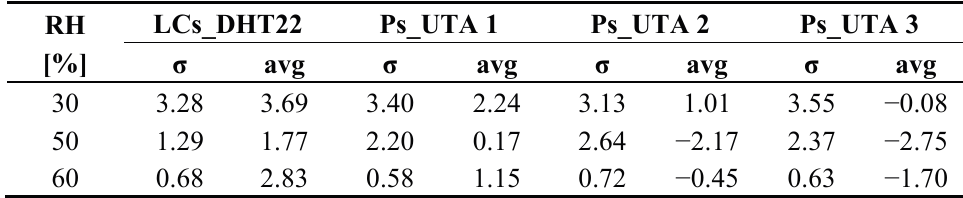
Table 4. Residuals analysis of the relative humidity: standard deviation ( σ ) and average (avg) of the values detected by LCs and Ps related to climatic box